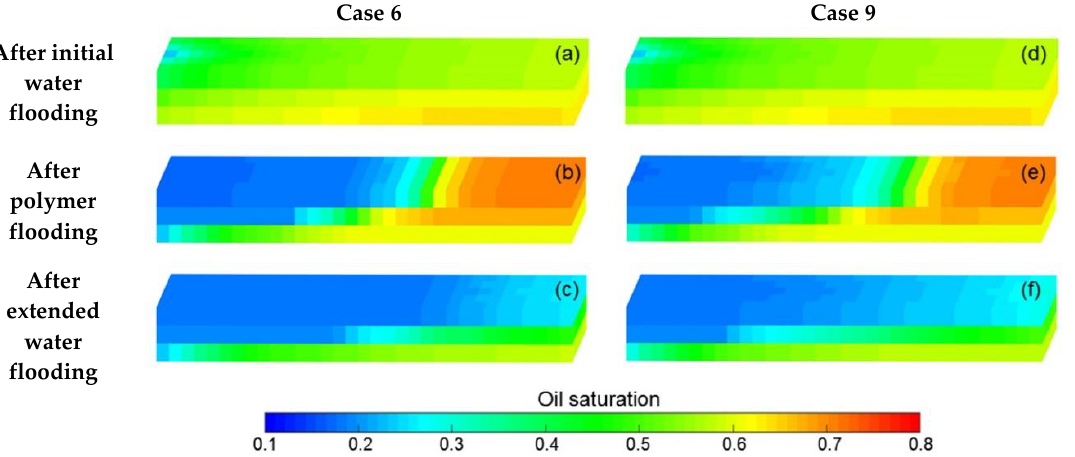
Figure 15. 3D remaining oil saturation distributions after ( a ) initial water flooding, ( b ) polymer flooding and ( c ) extended water flooding of Case 6, and those results after ( d ) initial water flooding, ( e ) polymer flooding and ( f ) extended water flooding of Case 9.